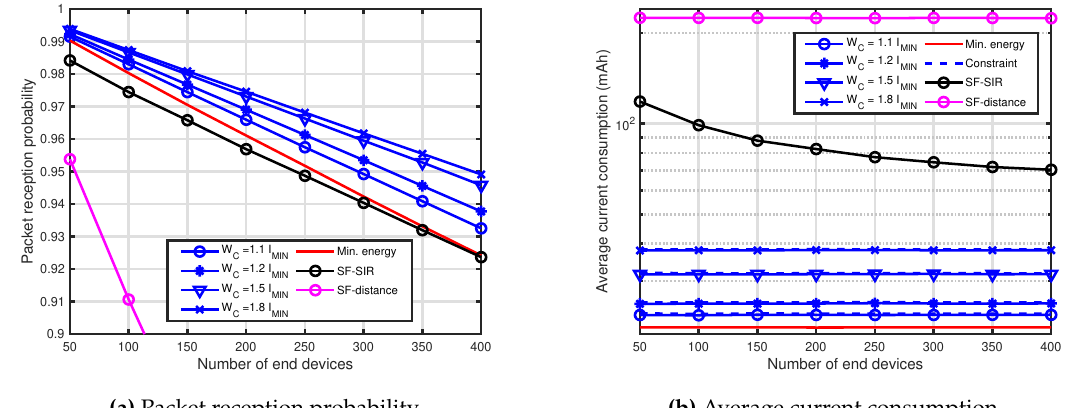
= 1.1 I mAh, 1.2 I C MIN